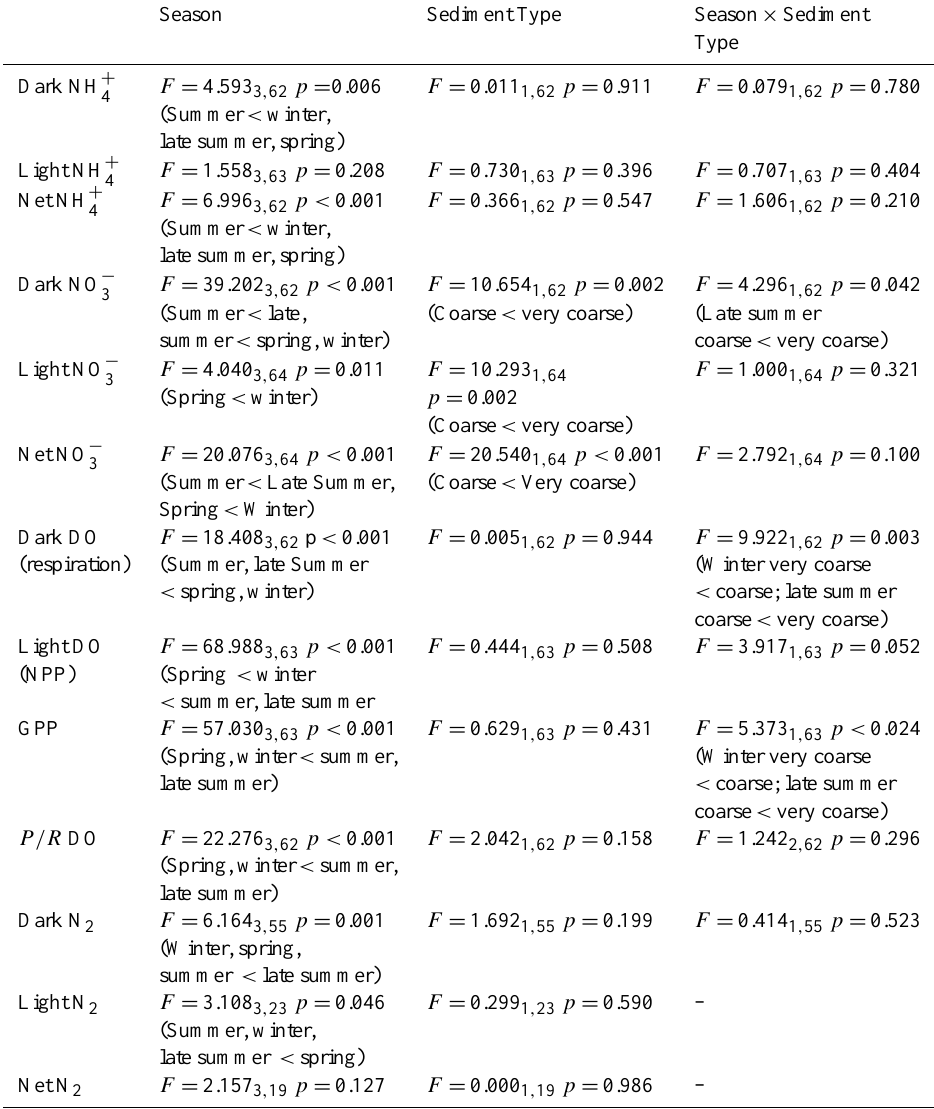
Table 2. Results from linear mixed model analysis of the effect of season and sediment type on benthic